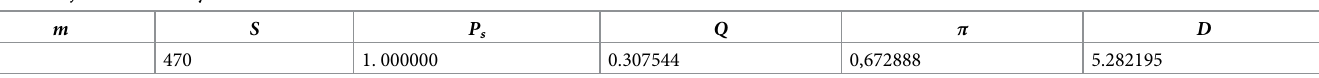
Table 1. Tajima’s neutrality